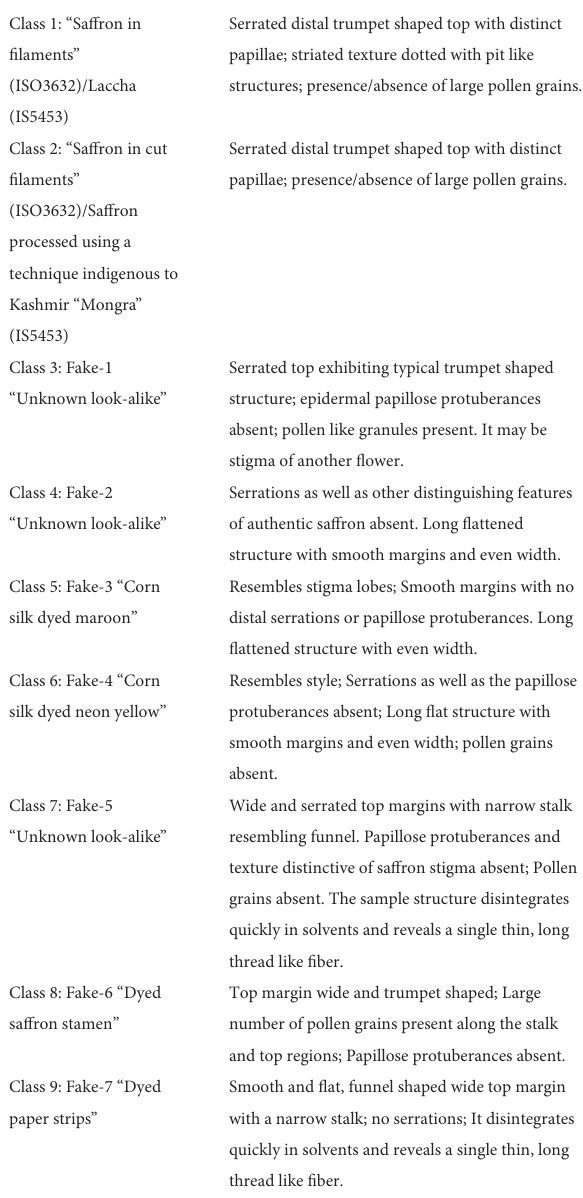
TABLE 1 Distinctive morphological features in saffron and look-alikes as visualized using